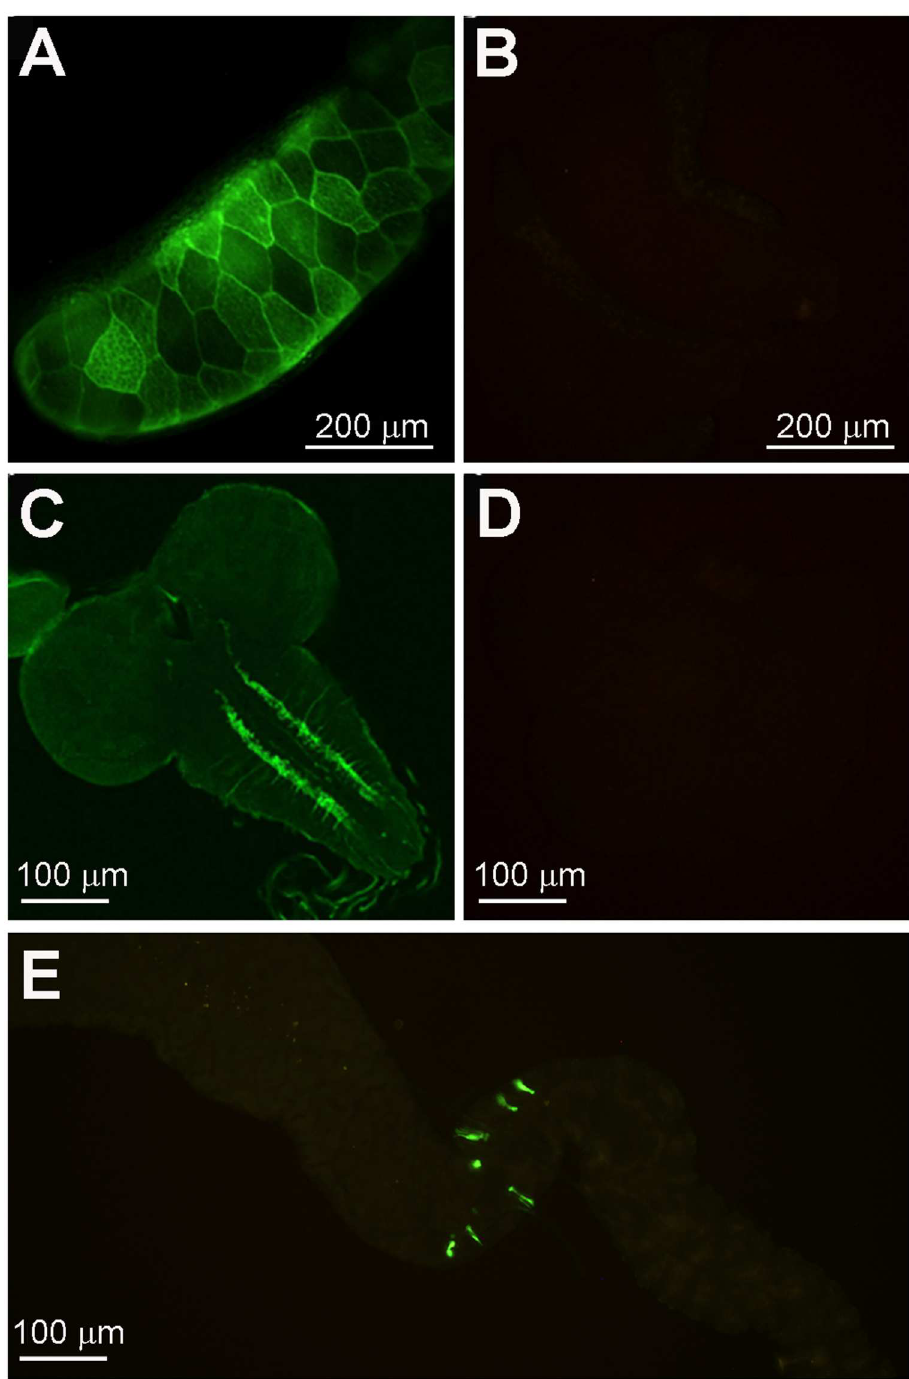
Fig 4. Expression of a Zip88E reporter gene is highly restricted. Expression of membrane-boundmCD8:: eGFP driven by Zip88E-GAL4 in third instar larval tissues. GFP expressionwas observedin the salivary glands(A, B = negativecontrol), in the ventral ganglion of the central nervoussystem (C, D = negativecontrol) and in a small number of enteroendocrine cells just anterior to the coppercell regionof the midgut (E). All images were recordedon a compoundfluorescence microscope at 10x (A, B, E)) or 20x (C, D) magnification. In A-D), larvae were fixed and immune-stained with an α -GFP antibodyfollowedby an FITC-conjugated secondary antibody. In E), native GFP signal without antibody stainingwas imaged.